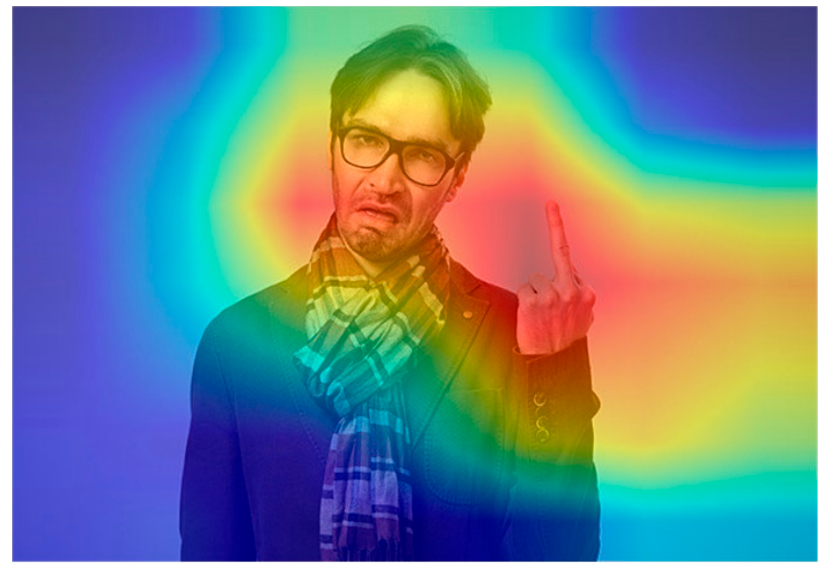
Figure 7. Heat maps on an image with discriminatory characteristics.